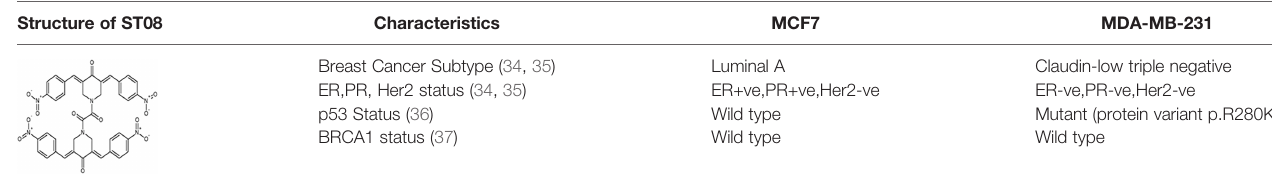
TABLE 1 | Molecular Signatures of the cell lines in the study. Structure of